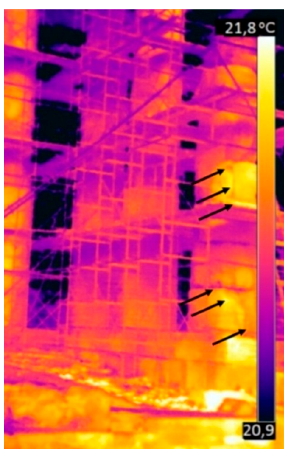
Figure 29. Thermal incompatibility between the antique and restoration materials.